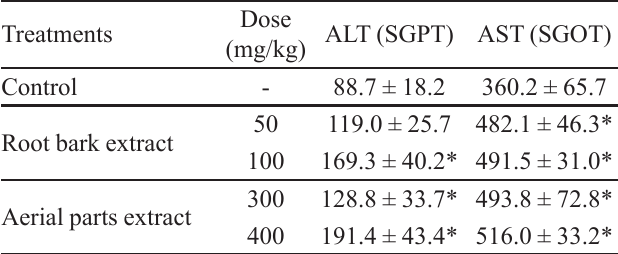
TABLE IV - Effect of subacute administration of D. americana extracts on serum transaminase levels (U/L) in mice Treatments